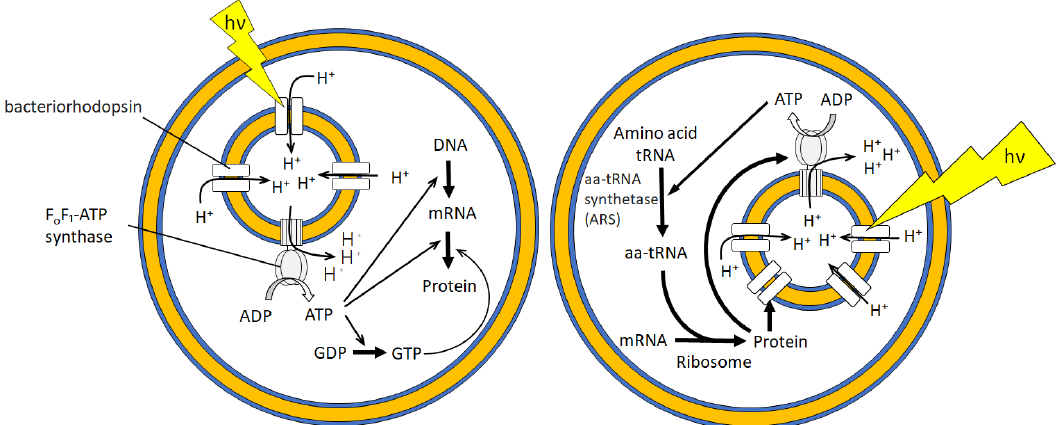
Figure 5. Schematic illustration of artificial photosynthetic cells exhibiting protein (GFP) synthesis inside GUV ( left ) and self-constituting protein synthesis ( right ) driven by light.